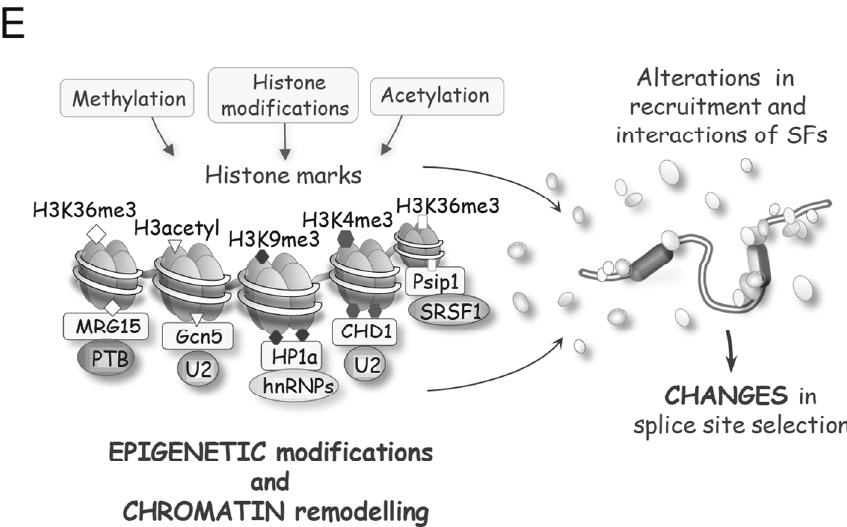
Figure 3. Molecular mechanisms controlling splice site selection. ( A ) A variety of splicing regulators, including hnRNP and SR proteins, bind to exon or intron splicing enhancers (ESE or ISE, respectively) and to exon or intron splicing silencers (ESS or ISS, respectively) to control splice site recognition and utilization; (B ) The activity of splicing regulators